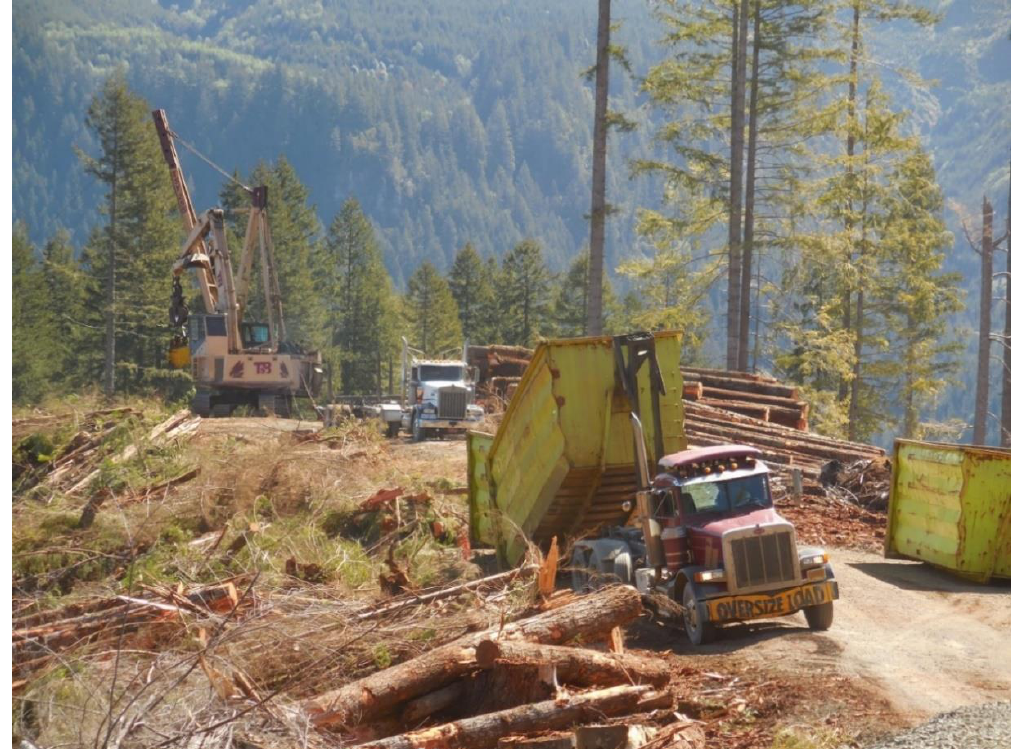
Figure 2. Skyline yarding and landing operational phases in the study comprised: (a) one yarder, (b) one loader, (c) one roll-o ff truck, (d) eleven roll-o ff containers, (e) two chasers, and (f) three choker setters.